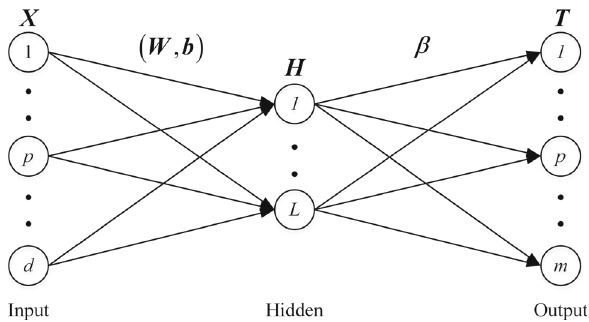
Fig. 1 Network structure of the